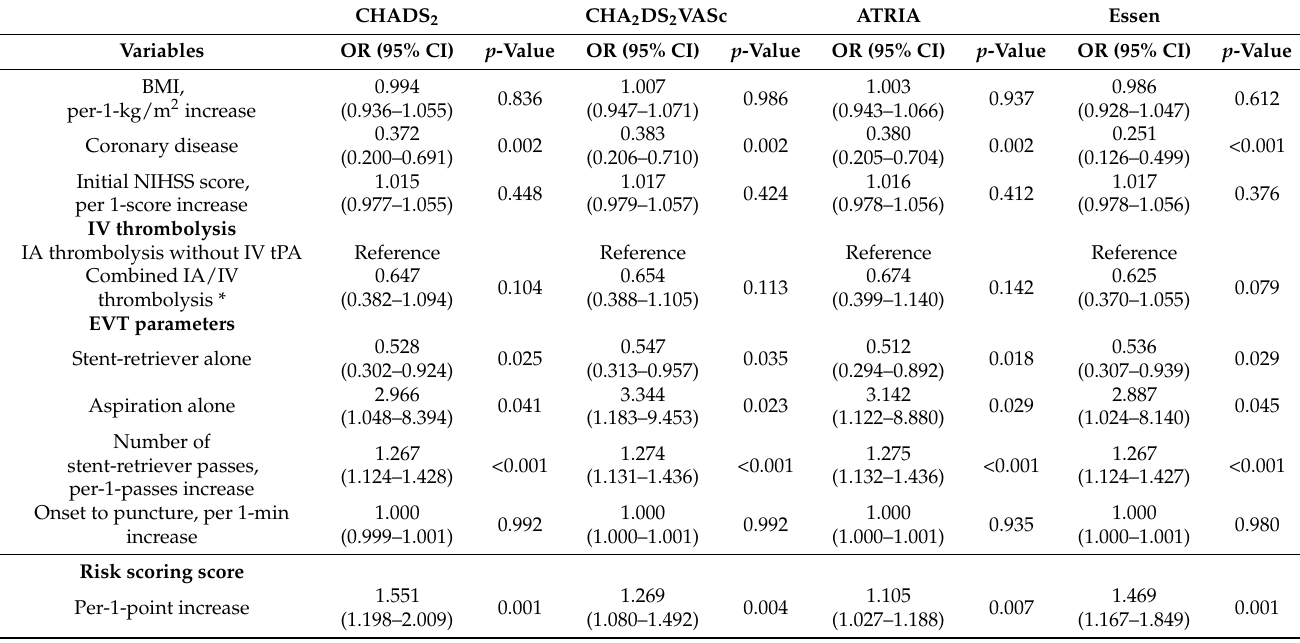
Table 2. Multivariable analysis for stroke risk score associated with the unsuccessful recanalization among 501 patients with endovascular thrombectomy. CHADS 2 CHA 2 DS 2 VASc